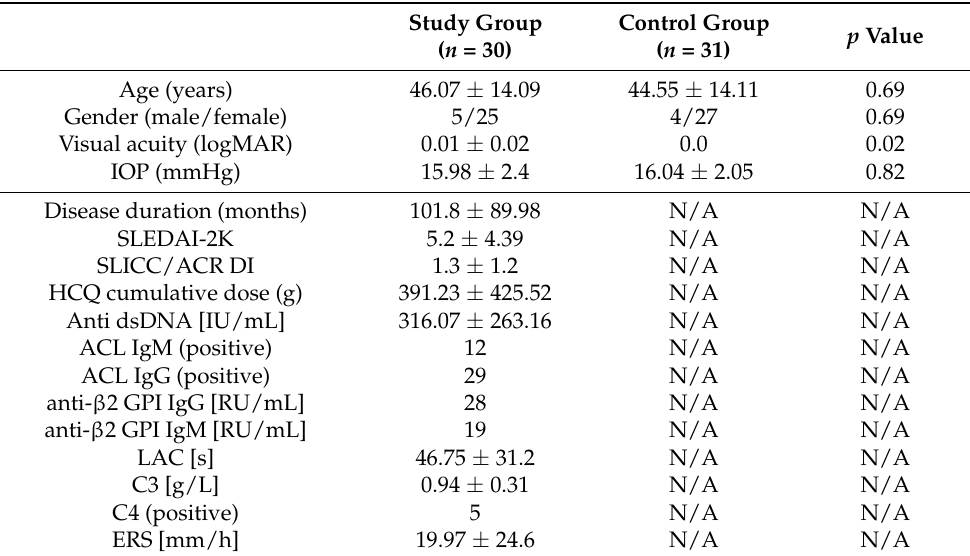
Table 1. Basic characteristics.